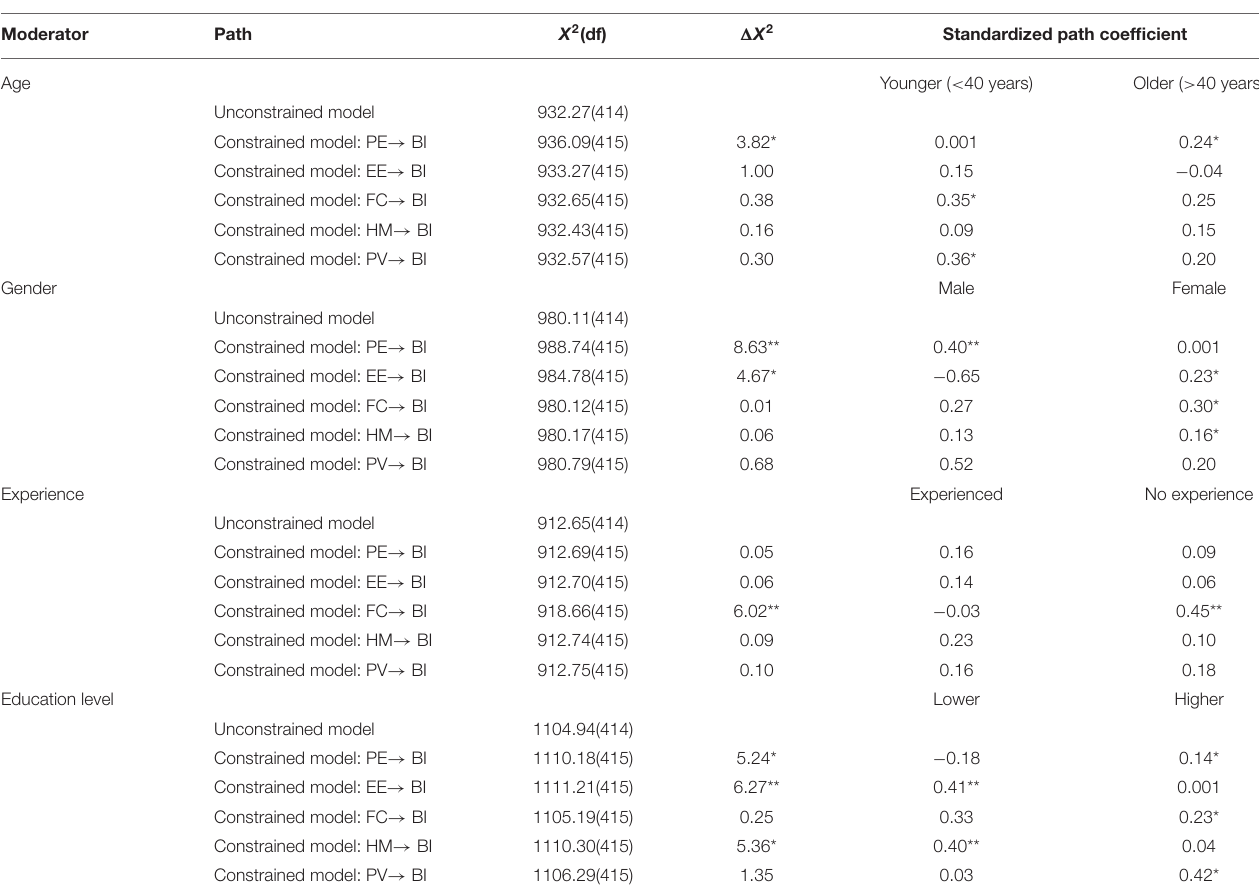
TABLE 6 | Results for moderating effects